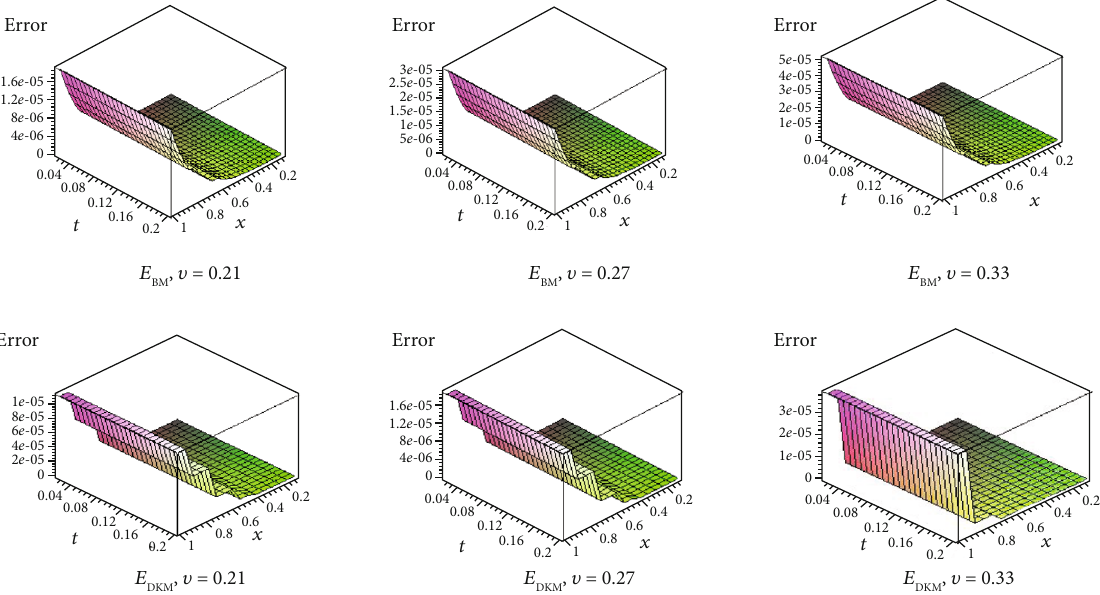
Figure 4: The values of errors by B-by-BM and DKM at T = 0 : 2 , N = 20 , and k = 1 for υ = 0 : 21, 0 : 27, 0 : 33